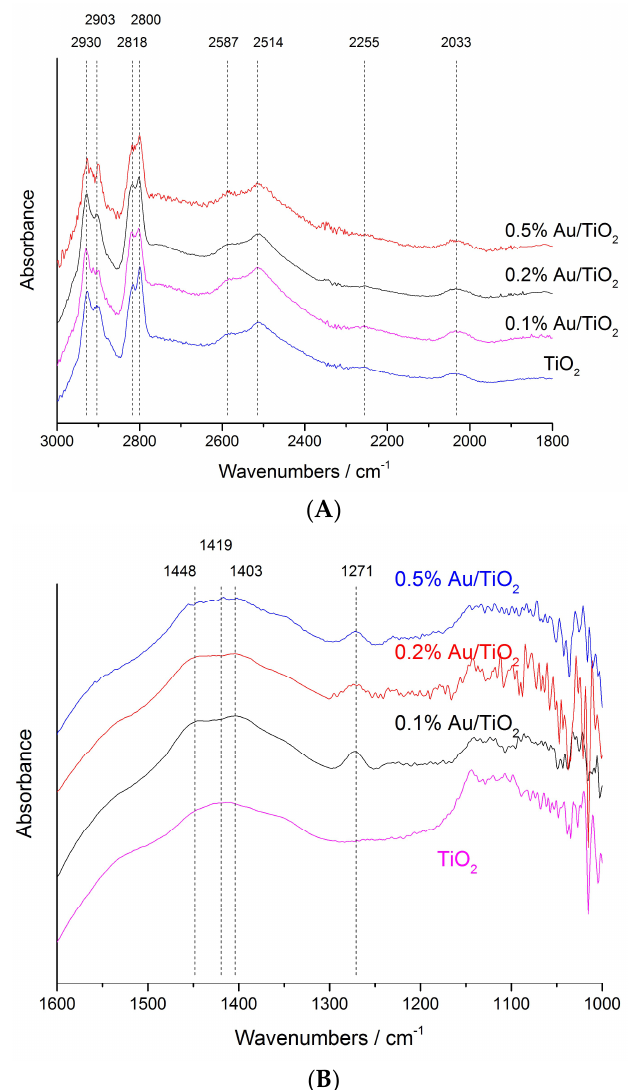
Figure 4. ( A ) DRIFTS spectra recorded as a TiO 2 -supported gold sample was treated in flowing mixtures of methanol and N 2 in 3000-1800 cm −1 spectral region. ( B ) DRIFTS spectra recorded as a TiO 2 -supported gold sample was treated in flowing mixtures of methanol and N 2 in 1600–1000 cm −1 spectral region (down).